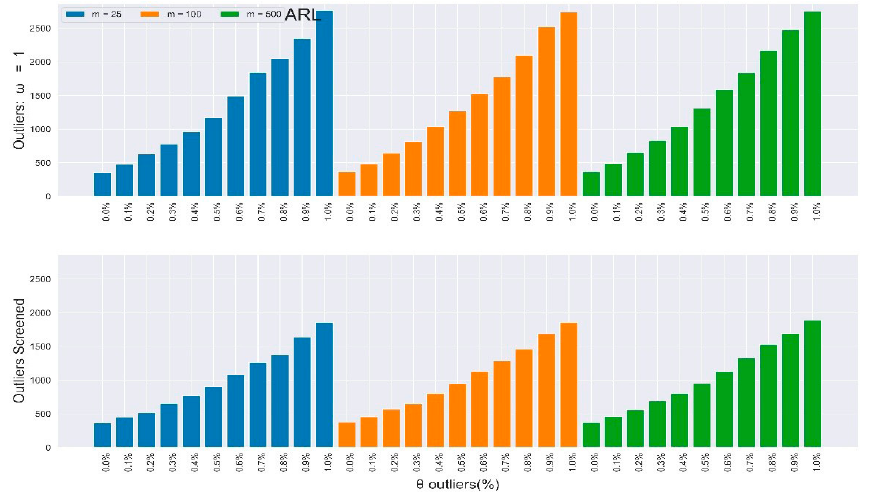
Figure 2. In-control ARL values of the multivariate Shewhart chart from mixed distribution with and without SDRE multivariate outliers screening ( ω = 1).